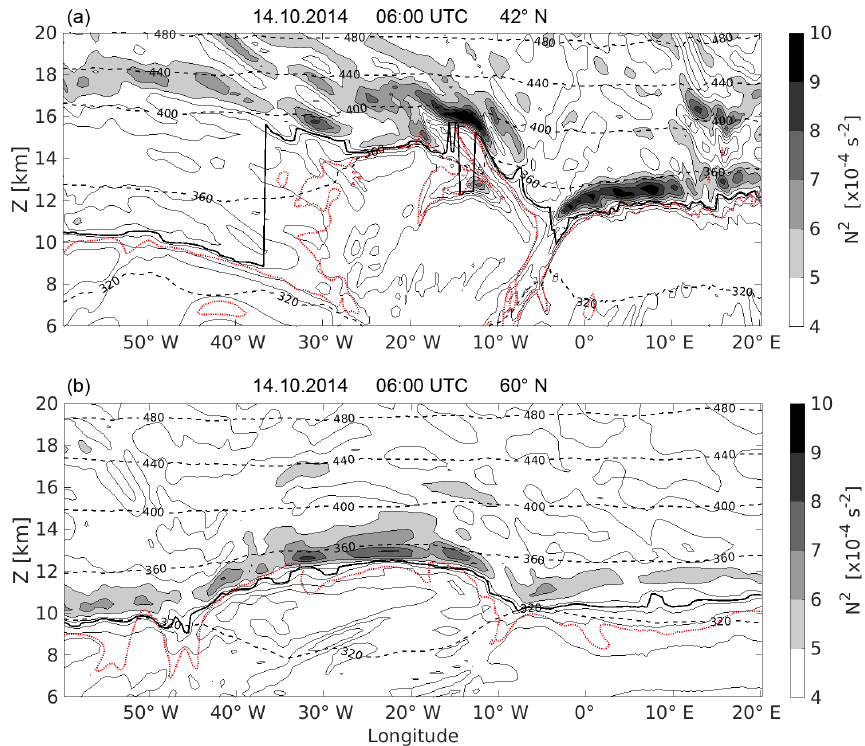
Figure 4. Vertical cross section over the North Atlantic on 14 October 2014 at 06:00UTC (a) at 42 ◦ N and (b) at 60 ◦ N. The filled contour as well as the thin solid black contour lines show static stability N 2 in steps of 1 × 10 − 4 s − 2 , dashed black lines show isentropes. The bold solid black line indicates the lapse rate tropopause, the dotted red line shows the 2pvu isoline of potential vorticity.